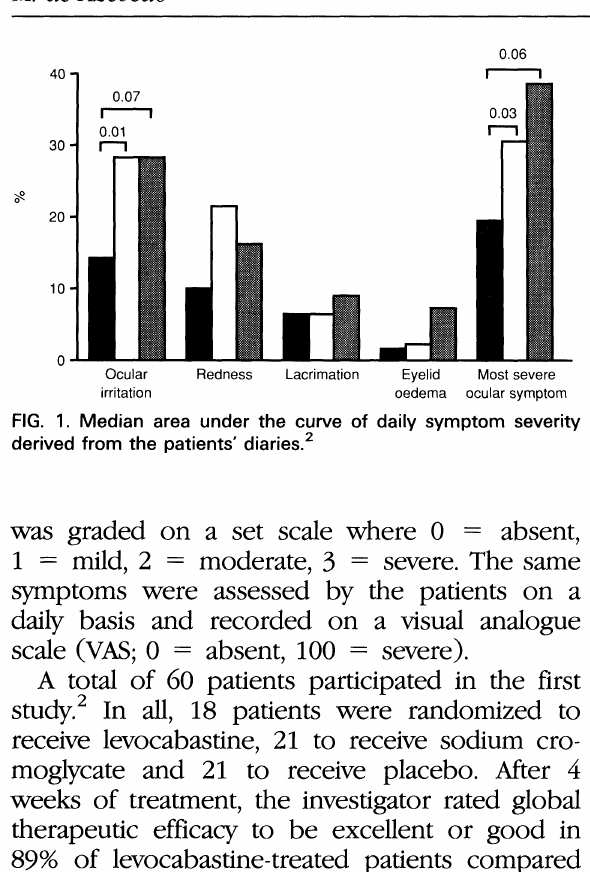
and 36% of those who received placebo (p